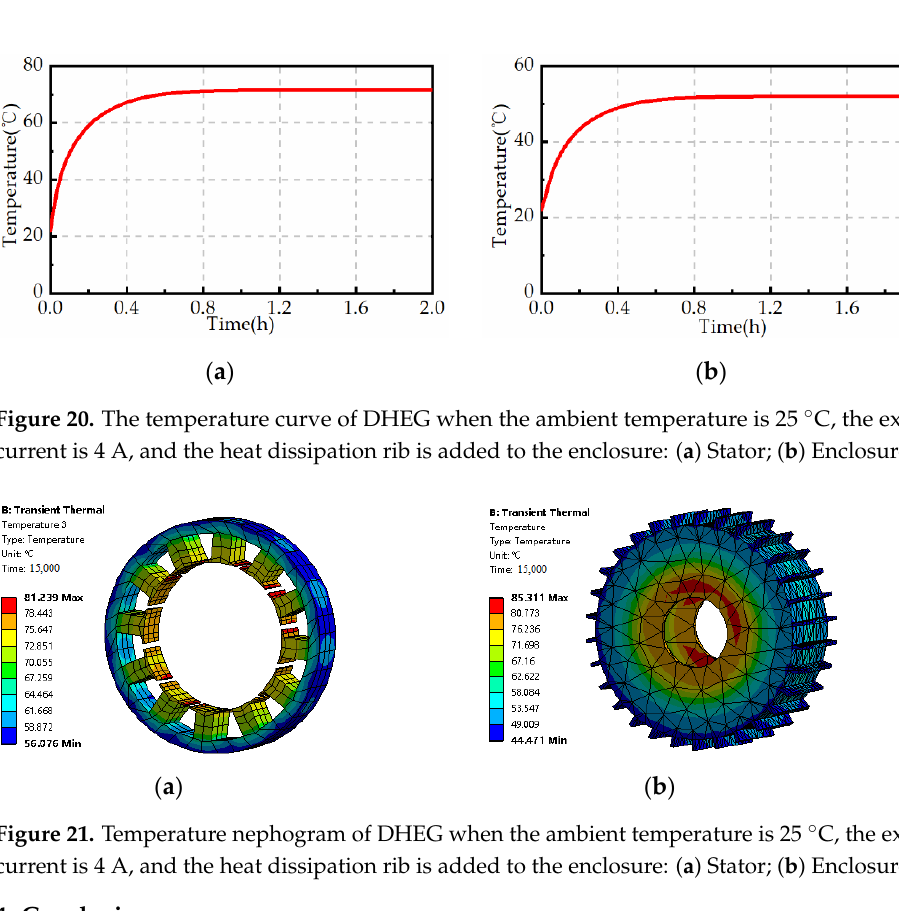
current is 4 A, and the heat dissipation rib is added to the enclosure: ( a ) Stator; ( b ) Enclosure.